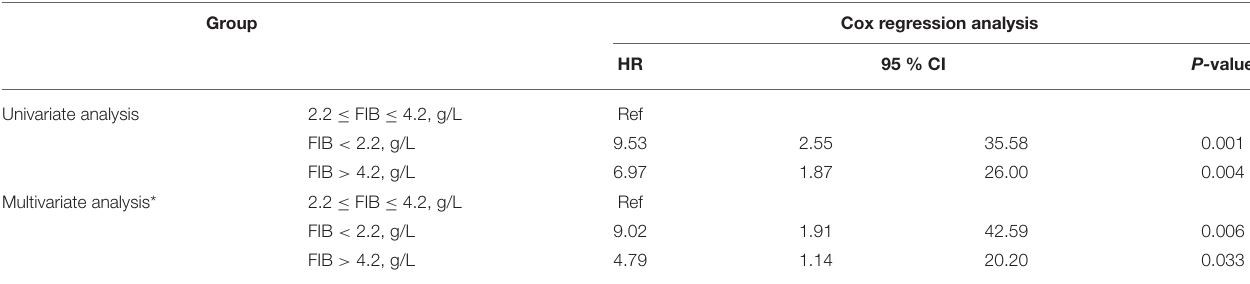
Multivariate analysis*